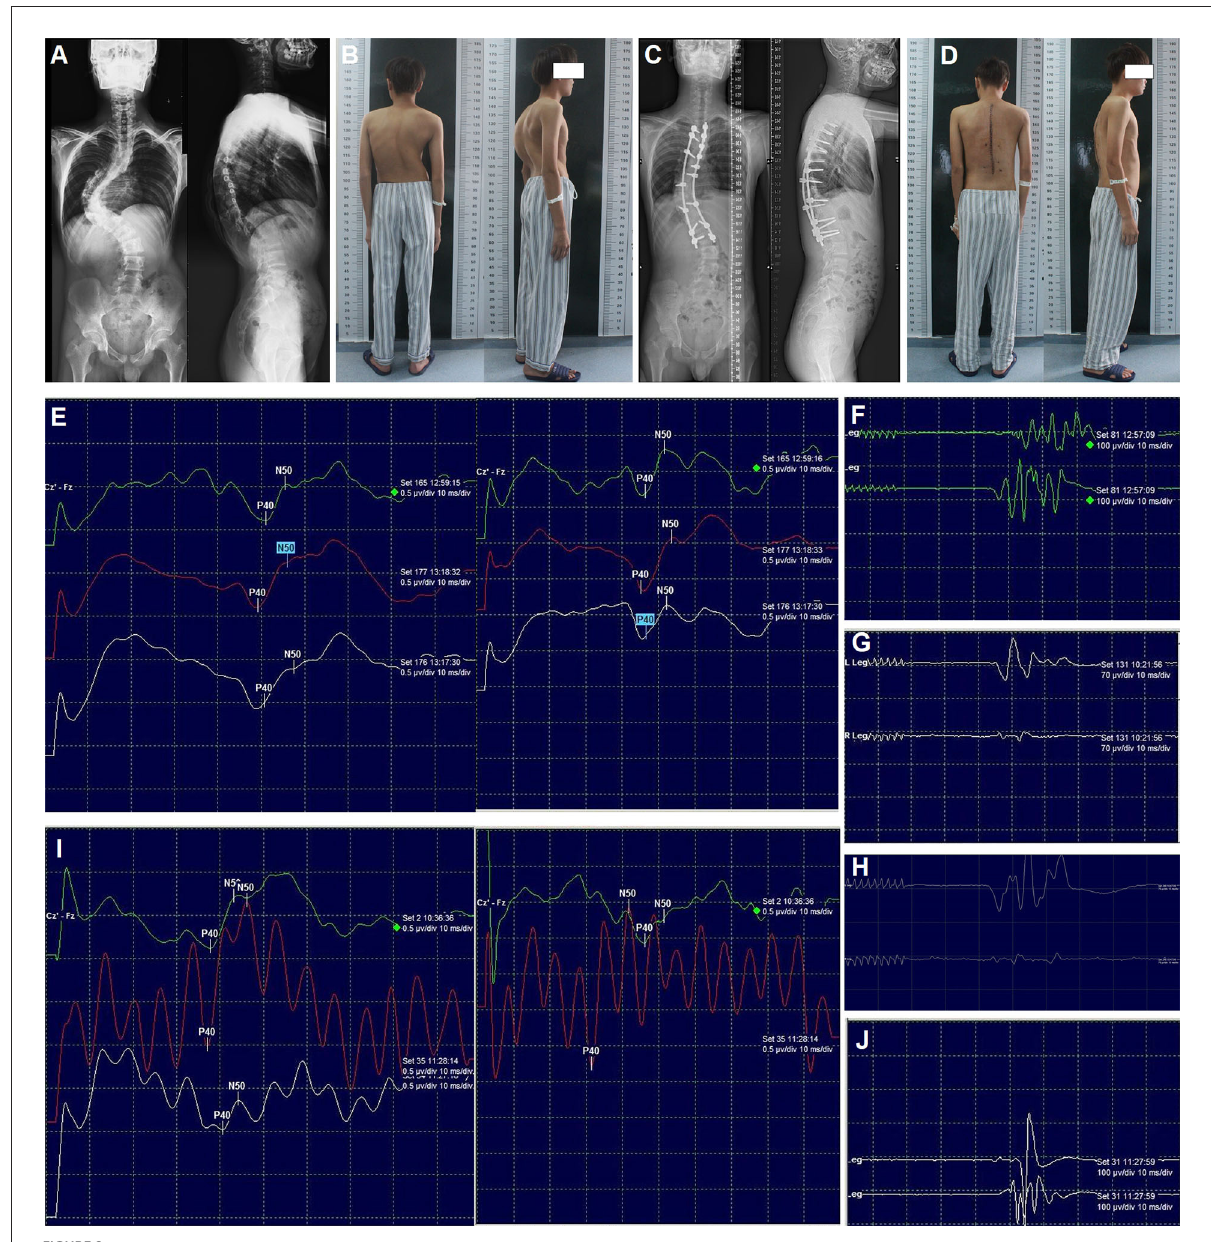
FIGURE2 Radiography, appearance, and intraoperative neurophysiological monitoring of case 1. Preoperative radiography of the entire spine (A) , preoperative appearance in the posterior and lateral views (B) , post-operative radiography of the entire spine (C) , post-operative appearance in the posterior and lateral views (D) . SEPs (E) and MEPs (F) after correction; MEPs of the left (G) and right (H) lower limb after laminectomy; SEPs (I) and MEPs (J) after spinal cord transposition. MEPs: Motor-evoked potentials; SEP: Somatosensory-evoked